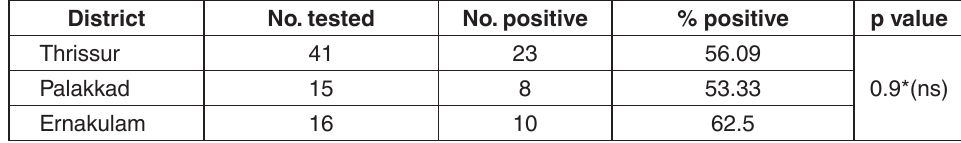
table 5. District - wise seroprevalence of toxoplasmosis District No. tested No.